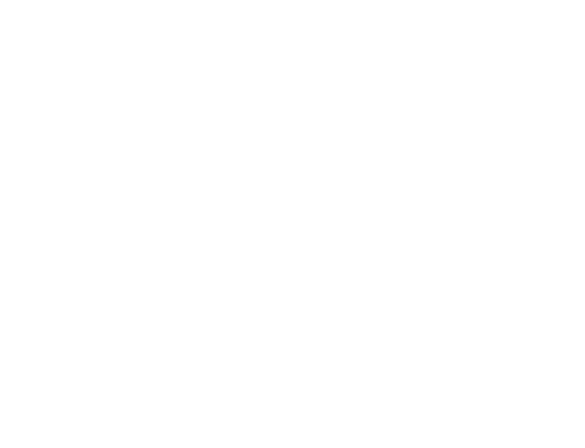
Figure 7. Diagrammatical analysis of the buoyancy of an air parcel that ascends adiabatically from the surface. The blue and red solid lines represent the vertical profiles of the mean moist entropy and the saturation moist entropy in the tropics, respectively. If a surface air parcel ascends adiabatically, its moist entropy and saturation moist entropy follow the black dashed line and the green dashed line, respectively, from the surface level A/B to the lifted condensation level C, the level of free convection D and finally to the cloud top E. Its buoyancy is directly proportional to the difference in entropy between the green line B–C–E and the red line.